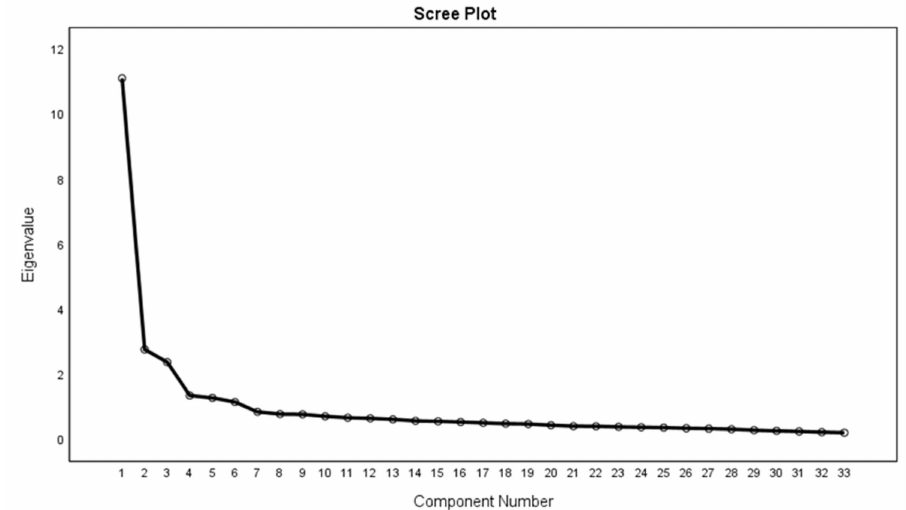
Figure 1. Screen